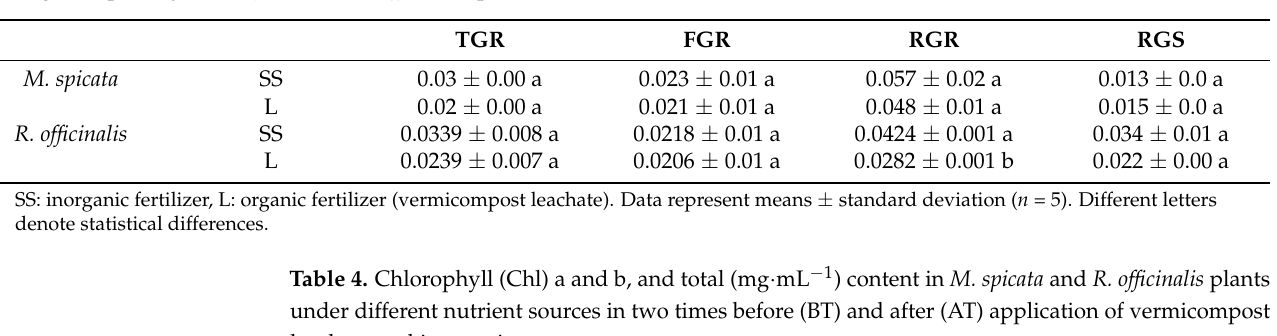
Table 3. Total growth rate (TGR), foliar growth rate (FGR), root growth rate (RGR), and stem growth rate (SGR) expressed in grams per day of M. spicata and R. officinalis plants.